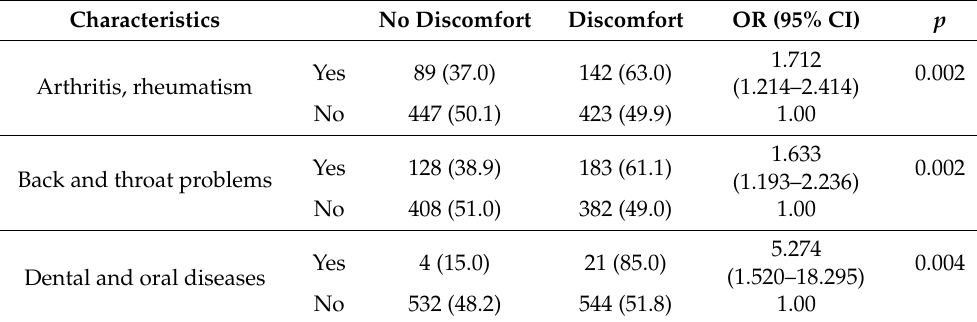
Table 3. Comparison of activity limitation due to masticatory discomfort.